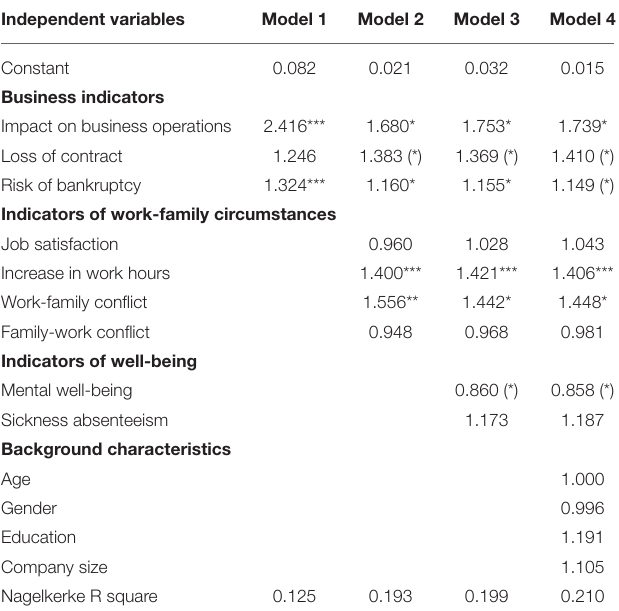
TABLE 3 | Logistic regression.